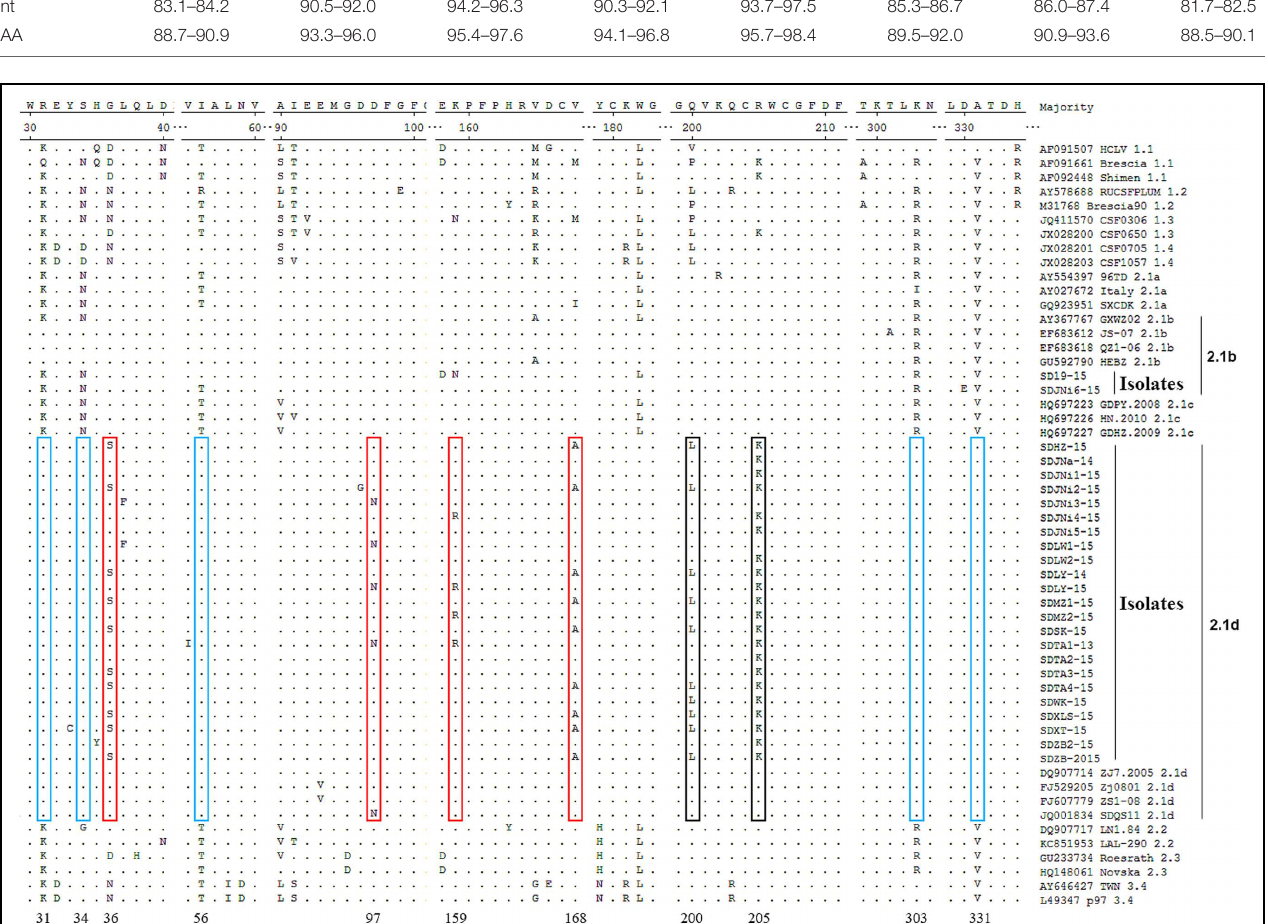
FIGURE 3 | Amino acid (AA) sequences alignments of E2 genes of the 25 new isolates and 29 representative CSFV isolates. Consistent molecular characteristics of 2.1d strains were indicated by blue boxes ( (cid:3)(cid:3)(cid:3) ). Unique AA substitutions of 2.1d strains compared with all other strains were indicated by red boxes ( (cid:3)(cid:3)(cid:3) ). Unique AA substitutions of 2.1d strains compared with subgenotype 2.1a, 2.1b, and 2.1c strains were indicated by black boxes ( (cid:3)(cid:3)(cid:3) ).